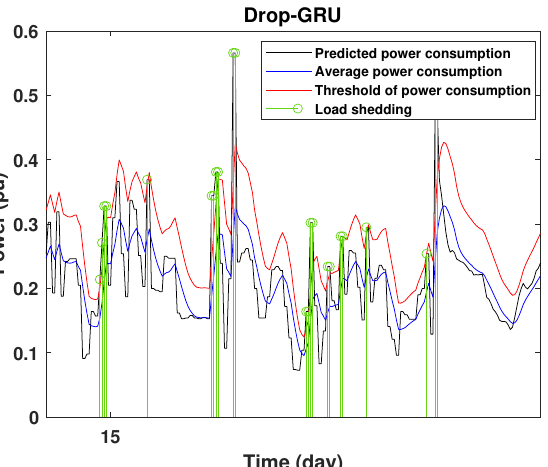
Figure 22. Detection of power consumption peaks during 1 days using the Drop-GRU